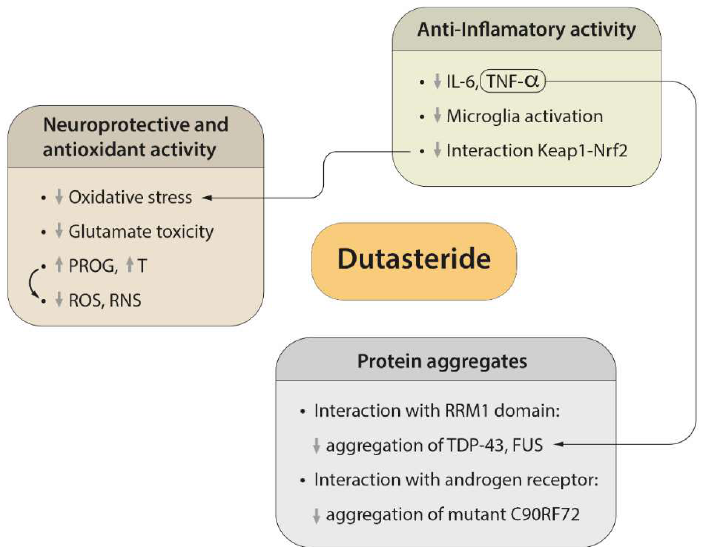
Figure 2. Dutasteride main effects to improve clinical outcome in ALS patients. Dutasteride decreases oxidative stress, including reactive oxygen species (ROS) and reactive nitrogen species (RNS), as well as glutamate toxicity, and increases progesterone (PROG) and testosterone (T) in systemic circulation, which promotes neuroprotection. It also has anti-inflammatory activity that prevents microglia activation and reduces the pro-inflammatory cytokines IL-6 and TNF-α. Moreover, it interacts with Keap1–Nrf2, which, in turn, contributes to the anti-inflammatory effect and oxidative stress. Finally, because of the interaction with the RRM domain, it could reduce the aggregation of TDP-43 and FUS, and because of the interaction with the androgen receptor, it may reduce the aggregation of mutant C9ORF2. ↓ : decrease of certain activity (oxidative stress, glutamate toxicity, microglia activation, interaction Keap1-Nrf2, or aggregation of TDP-43, FUS or mutant C90RF72), or PROG, T, IL-6 or TNF-α blood levels, or ROS/RNS decrease. ↑ : increase of PROG or T blood levels.